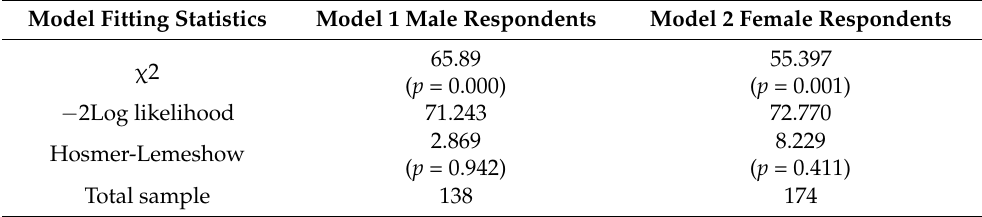
Table 3. Goodness of fit